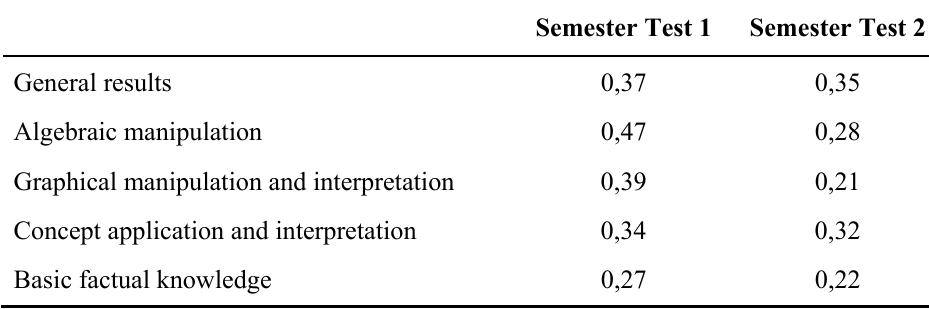
Figure 6 : Student performance in factual knowledge and concept application in Semester Tests 1 and 2 The correlation coefficients between student performance in each of the components and their Grade 12 performance are given in Table 1. Table 1 : Correlation coefficients between university and Grade 12